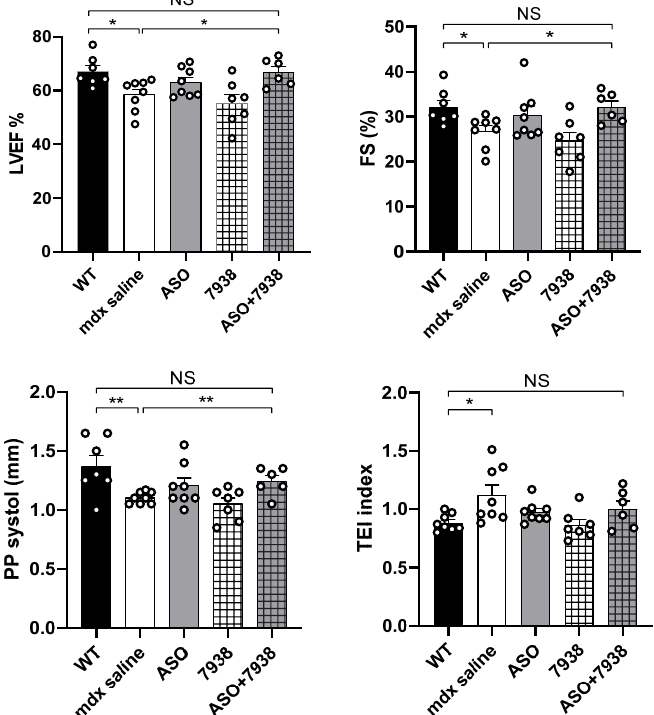
Figure 4. The combination of tcDNA-ASO and UNC7938 treatment improves cardiac function in mdx mice. Cardiac function was evaluated by echocardiography in six-month-old mice and the left ventricular ejection fraction (LVEF), the fractional shorting (FS), the systolic pulse pressure (PP sys- tole), and the Tei index are represented. Results are expressed as mean ± SEM; n = 8 for WT, mdx saline and ASO, n = 7 for 7938 and n = 6 for ASO + 7938. * p < 0.05, ** p < 0.01 analyzed by one-way ANOVA.